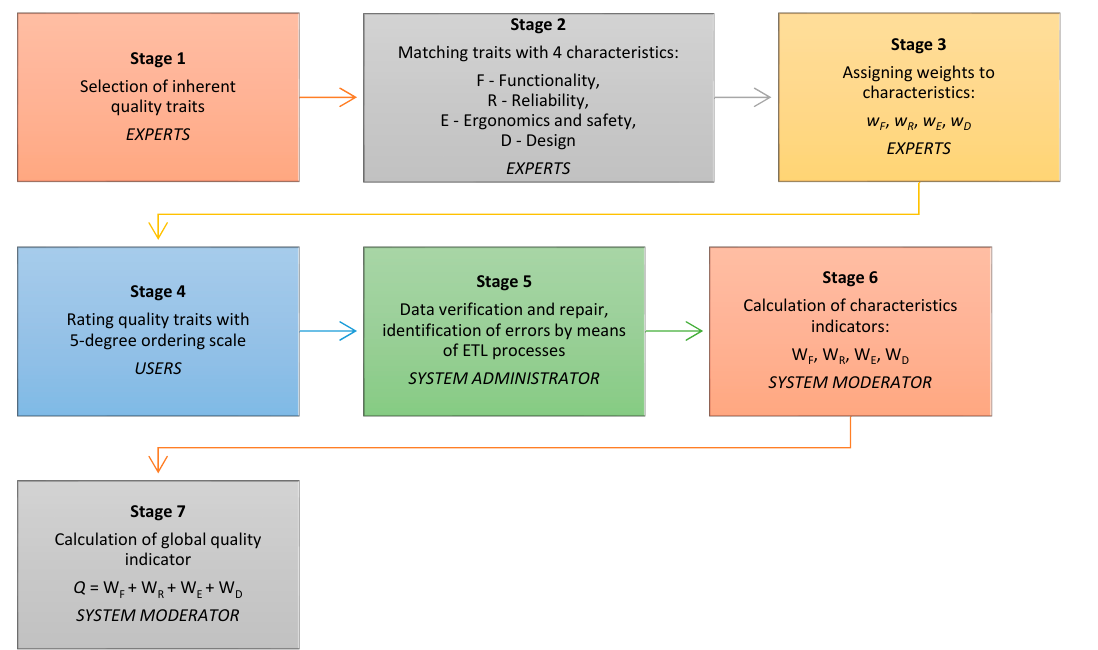
Figure 2. An algorithm of the quantification of the farming machinery and vehicles quality indicator, Q.